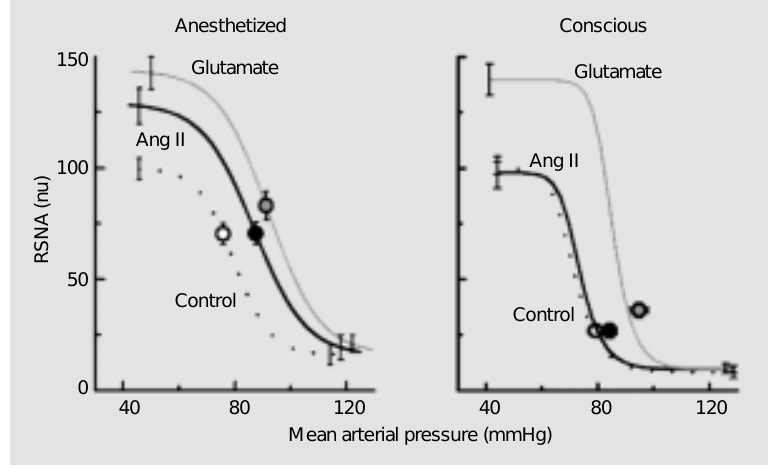
Figure 6. Average mean arterial pressure and renal sympathetic nerve activity (RSNA) curves before (control, dotted lines) and during infusion of Ang II (black lines) or glutamate (gray lines) into the rostral ventrolateral medulla in 6 urethane-anesthetized rabbits (left panel) or in 7 conscious rabbits (right panel). Error bars are average SEM calculated from analysis of variance indicating variation within animals. nu = normalized units. Adapted with permission from Mayorov and Head